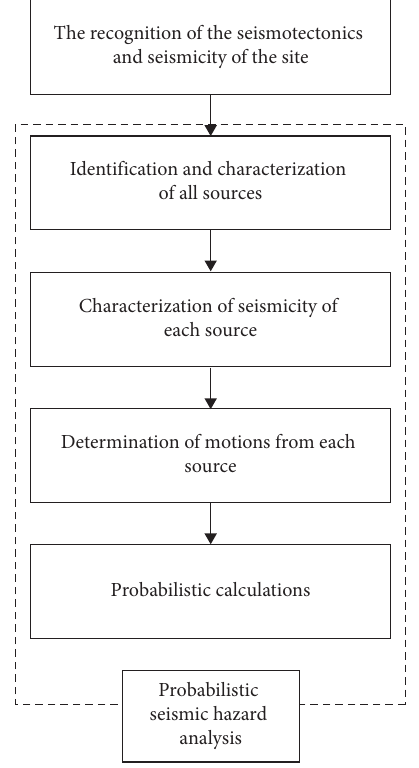
Figure 1: Process of probabilistic seismic hazard